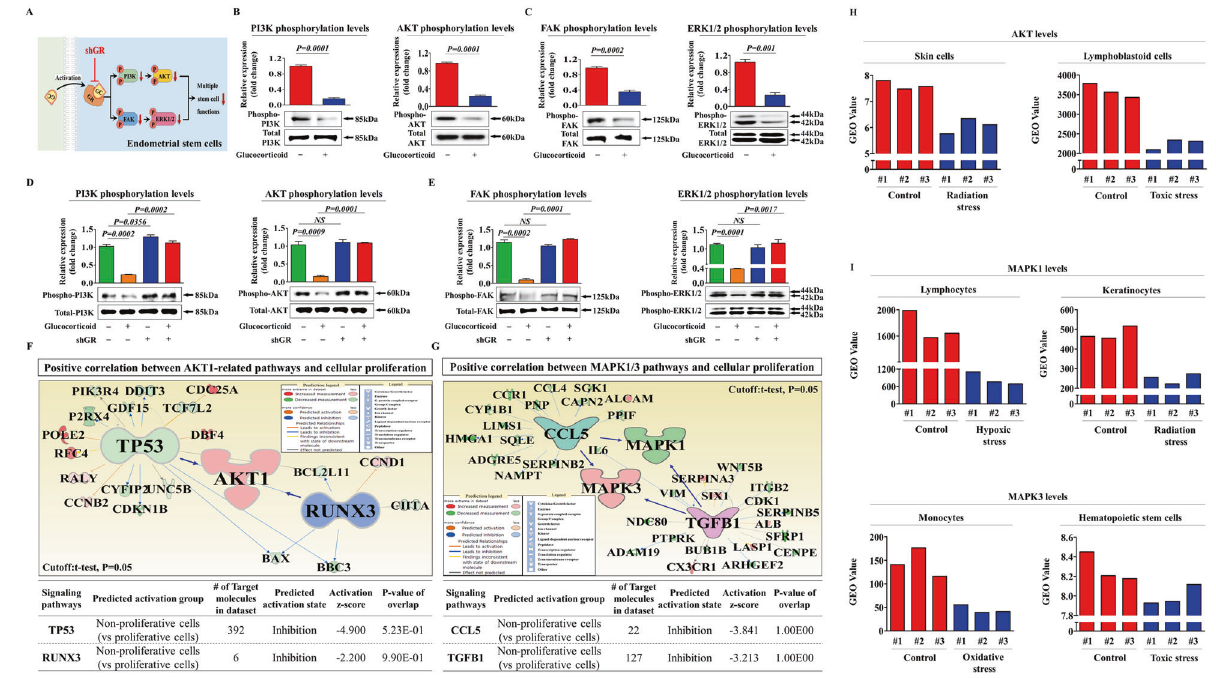
Fig. 4 Glucocorticoid-induced inhibitory effects are mediated through the PI3K/Akt and/or FAK/ERK1/2 signaling pathways in endometrial stem cells. A schematic diagram regarding the functional role of the FAK/ERK1/2 and/or PI3K/Akt signaling pathway in mediating glucocorticoid-induced effects is described ( A ). Endometrial stem cells were treated for 10 min with or without glucocorticoids (500 nM). The treated cells were washed with PBS and then lysed, and subsequent changes in protein expression were evaluated by western blotting. The activation states of these signaling molecules (Akt, PI3K, FAK, and ERK1/2) were signi fi cantly reduced in cells treated with glucocorticoids ( B , C ). Endometrial stem cells were cultured with glucocorticoids (500 nM) alone, or cells were concomitantly treated and transfected with a speci fi c shRNA targeting GR; subsequent changes in the activation states of PI3K, Akt FAK, and ERK1/2 were assessed by western blotting ( D , E ). Differentially expressed genes in proliferative cells and nonproliferative cells were investigated using IPA software to determine the activation states (either inhibited or activated) of the Akt1 (GSE116436) ( F ) or MAPK1/3 (ERK1/3) (GSE2034) ( G ) -related pathway/transcription factors. The GEO database was analyzed to further investigate the relationship between the levels of Akt ( H ) or MAPK1/ 3 ( I ) and various deleterious conditions, such as radiation stress, toxic exposure, or hypoxic stress. β -actin was used as the internal control. All experiments were performed in triplicates, and the data has been presented as mean ± standard deviation (SD). P -value under 0.05 was presented in fi